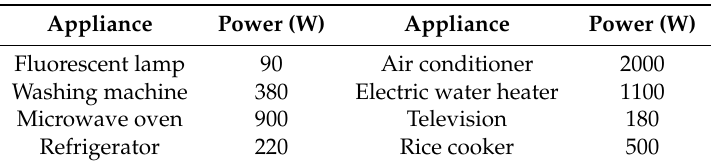
Table 1. Power of partial household